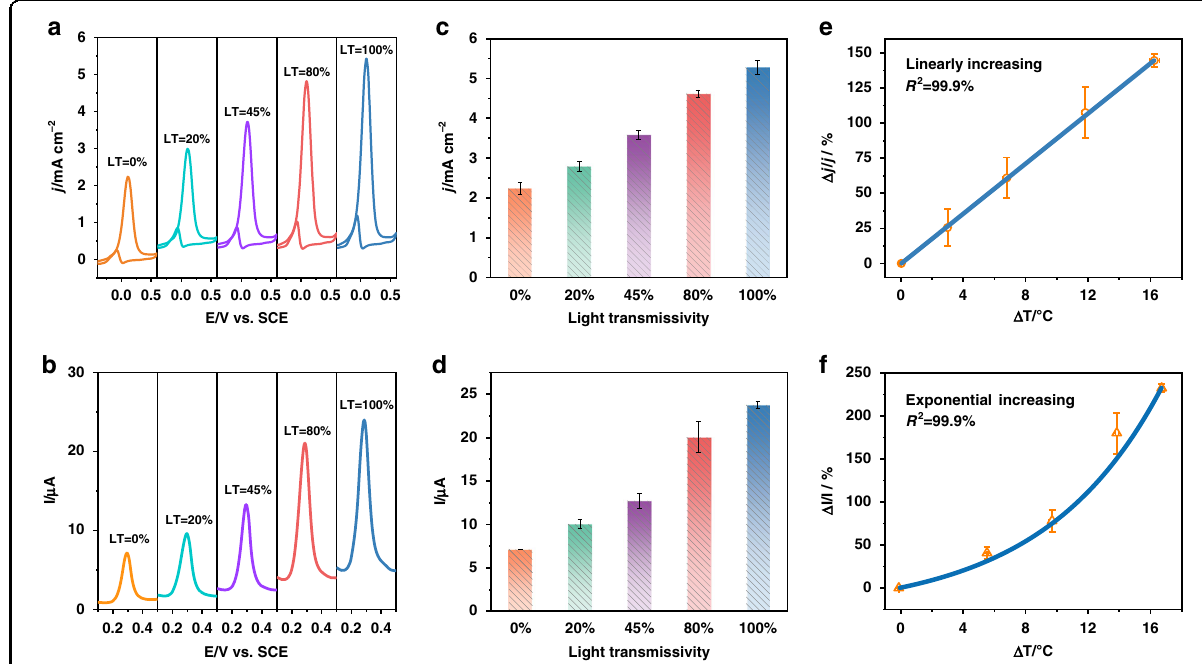
Fig. 6 Decoding the relationship between light power, surface temperature, and photo-electrocatalytic activities. a , b CV changes in 1 M ethanol and 1 M KOH solution ( a ) and DPV changes of 20 µM APAP in 0.1 M phosphate buffer (pH = 7.0) ( b ) with increasing light transmissivity (LT). c , d The corresponding histograms of electrochemical signals vs . power level for ethanol oxidation ( c ) and APAP detection ( d ). e , f Relationship between the electrocatalytic activity of ethanol oxidation ( e ), APAP detection ( f ), and the catalyst surface temperature. Error bars result from the standard deviation from fi ve